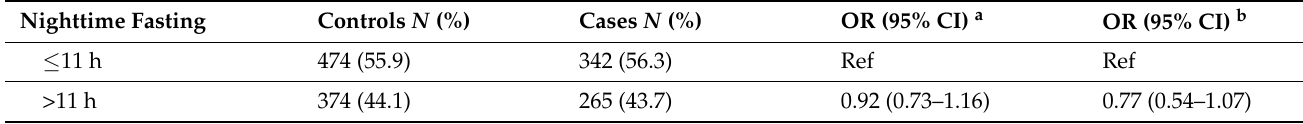
Table 3. Association of nighttime fasting and prostate cancer